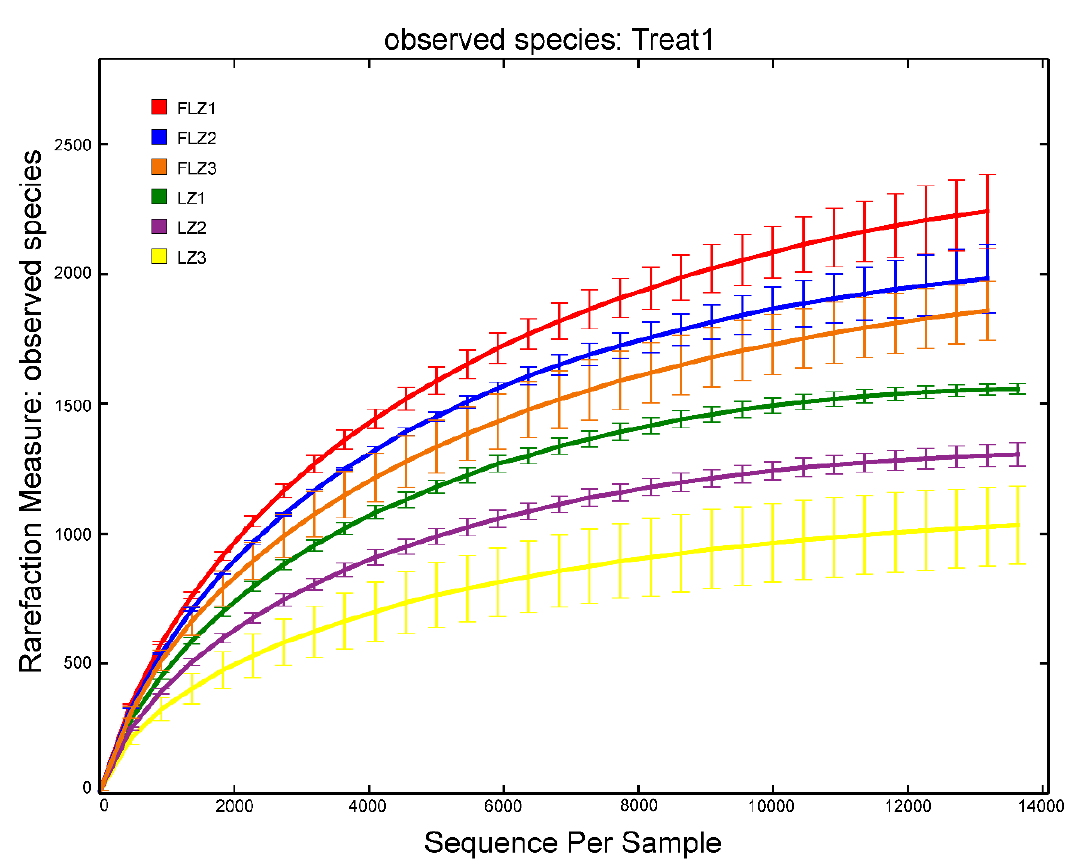
Figure 1. Rarefaction curves of bacterial communities based on observed OTUs at 97% sequence similarity for individual samples. LZ1, FLZ, LZ2, FLZ2, LZ3 and FLZ3 represent the soil samples collected from continuous cropping (LZ) and main cropping (FLZ) at the 4 May (LZ1 and FLZ1), 14 July (LZ2 and FLZ2) and 19 September (LZ3 and FLZ3), 2016. OTU classification and their status identification results were statistically analyzed to visually compare the differences of OTU numbers and classification status in six different samples (Table 3). For bacterial communities, phylum, class, order, family, and genus were counted to reflect their community structure in different soil samples. Compared to that in the continuous cropping soil, the count of phylum, class, order, and family were significantly higher in the main cropping soil, regardless of the sampling time. However, no notable difference in genus was observed between the main cropping and continuous cropping soil on 4 May